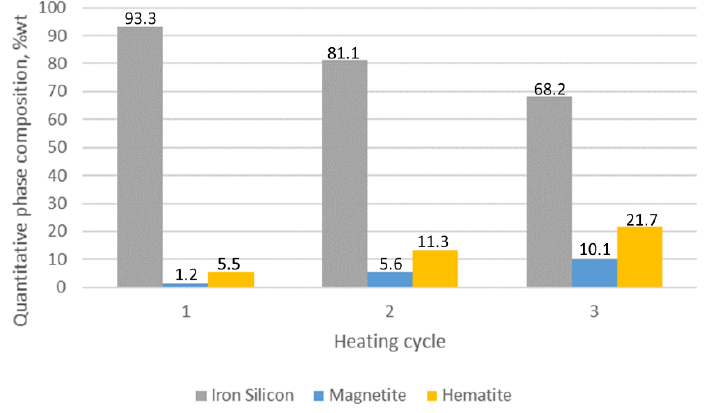
Figure 15. The quantitative share of outer oxide layer phase components for sample 2 as a function of heating cycles.